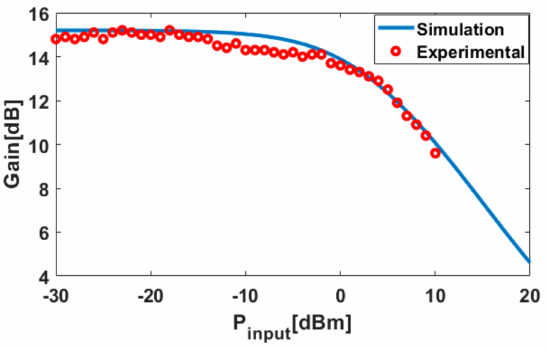
Figure 4. SOA gain as a function of input power. Simulation (solid line) and measured (dots) for wavelength = 1550 nm.